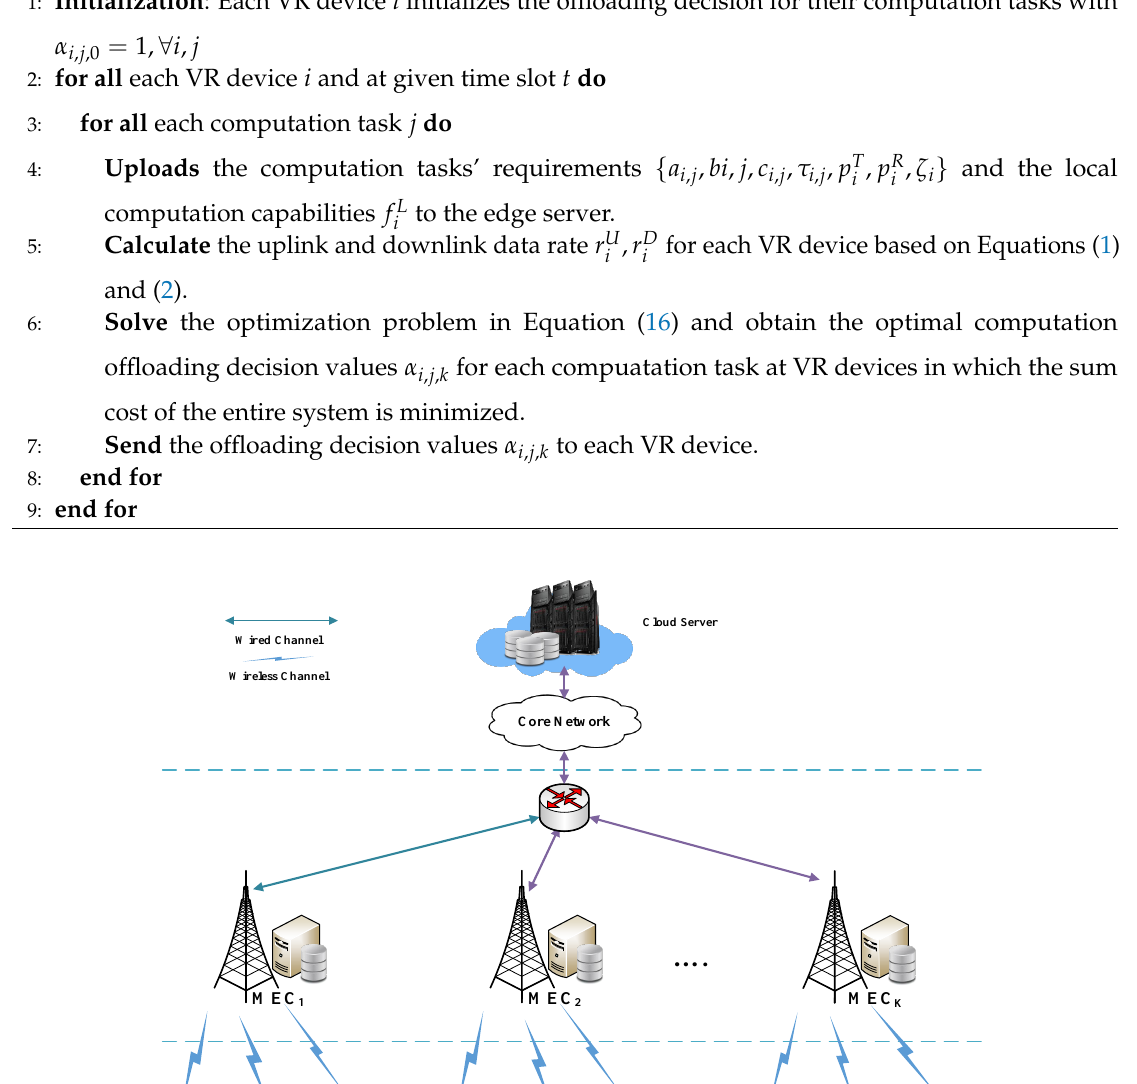
Algorithm 1 Multi-Player Computation Offloading Algorithm